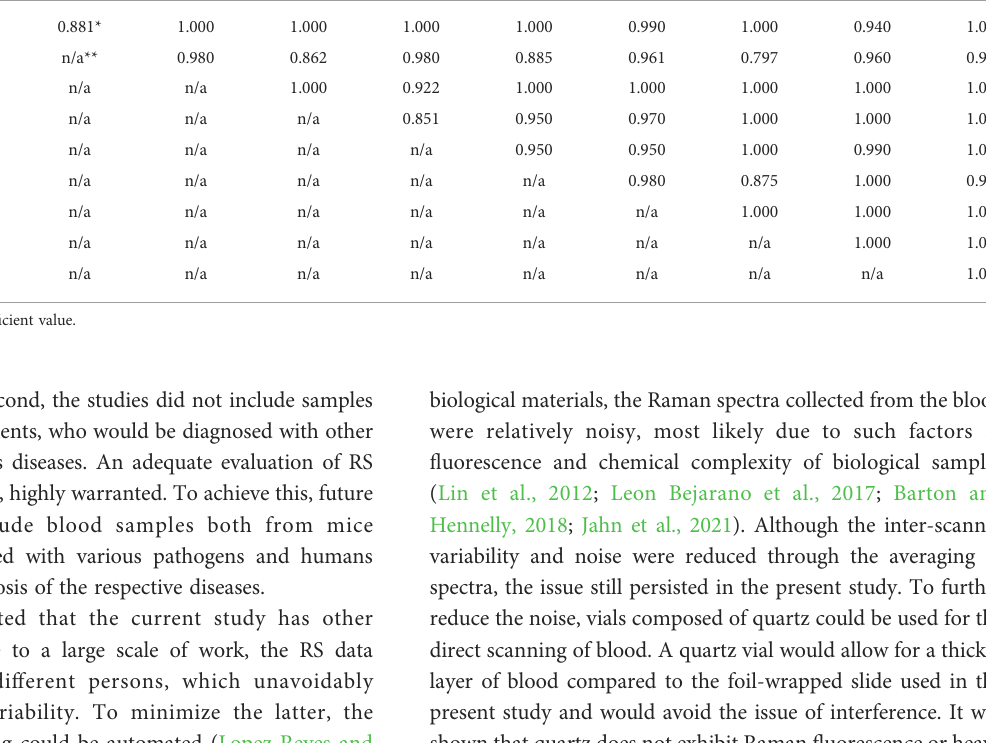
Days post infection